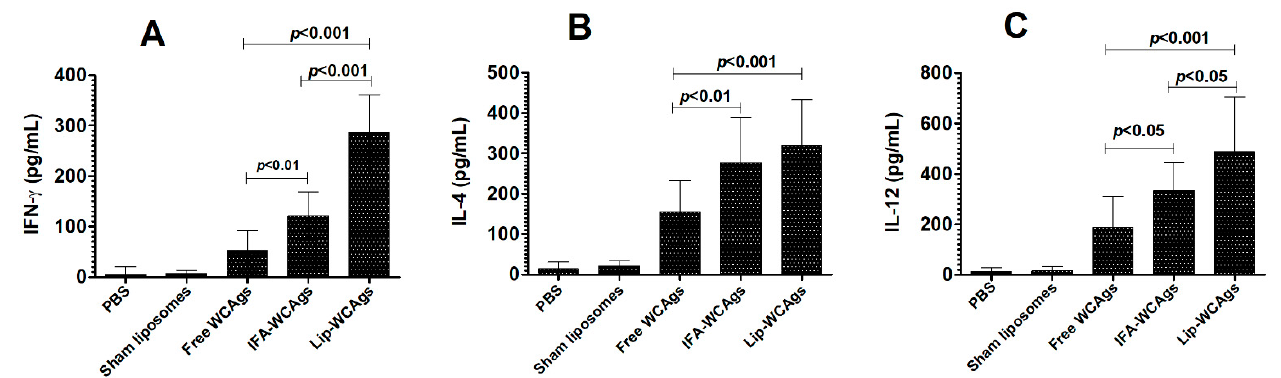
Figure 4. The splenocytes from Lip-WCAgs-immunized mice secreted larger IFN- γ and IL-12, but not IL-4. ( A ) IFN- γ , ( B ) IL-4, and ( C ) IL-12. The spleen cells were stimulated with WCAgs (10 μ g/mL) for 48 h. The supernatant was collected and the levels above-mentioned cytokines were analyzed. The data are expressed as mean ± SD.